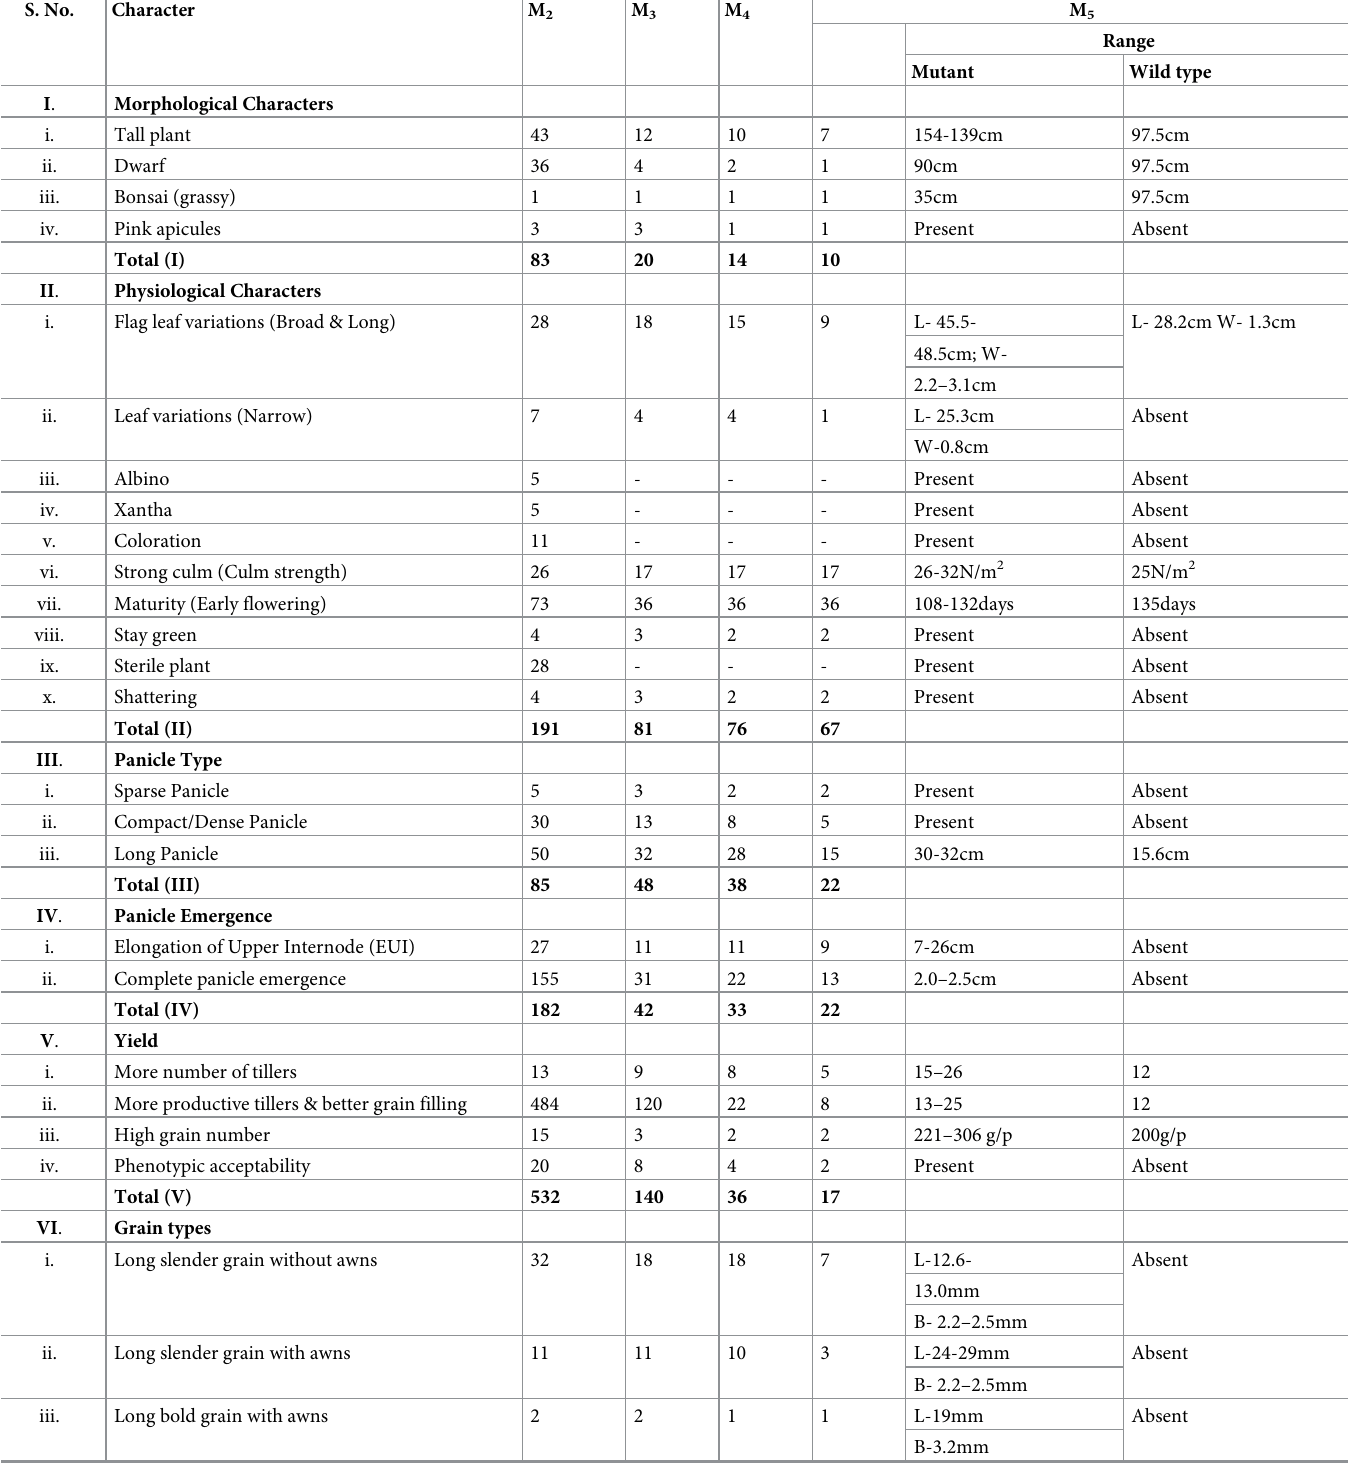
Table 1. Number of mutants exhibiting agronomically important traits from M 2 to M 5 Generation. S.